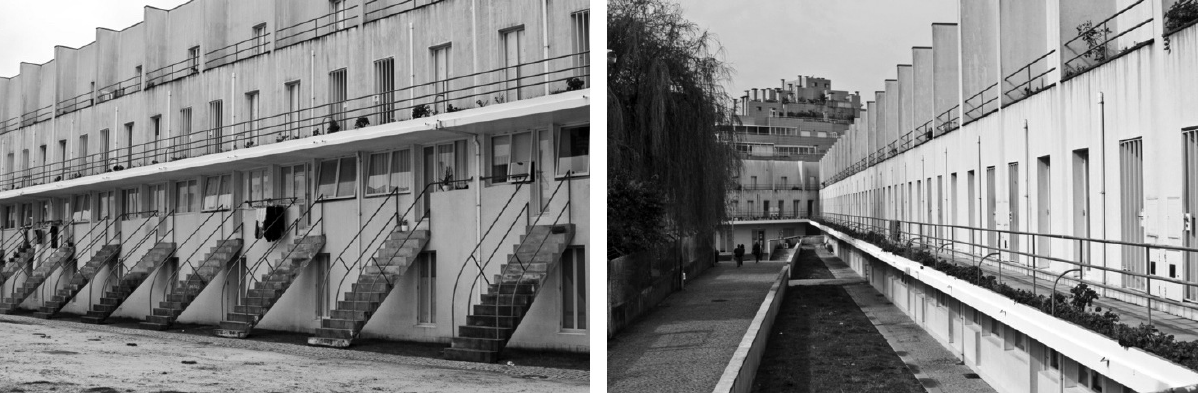
Figure 8. SAAL in Bouça Estate (Porto). General views in 2013: Phase 1, 1973–1978 (reference a826 in MdH database). Urban Planning, 2022, Volume 7, Issue 1, Pages